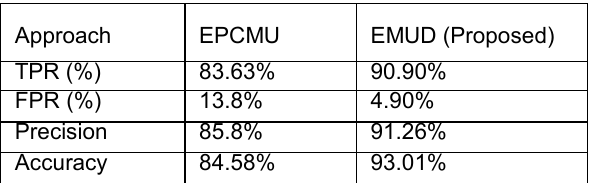
Table 7. Comparison of proposed model with